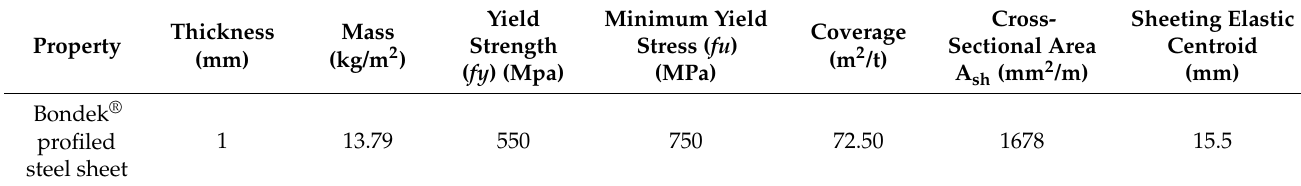
Table 4. Profiled steel sheet material